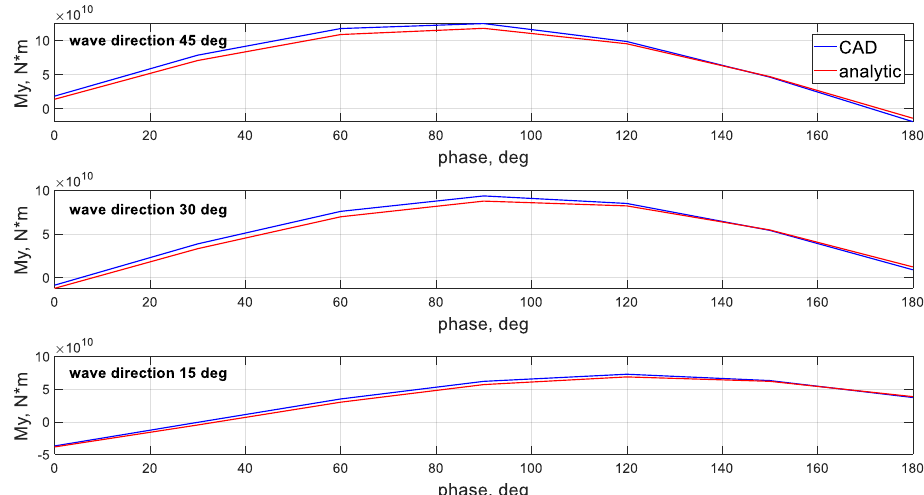
Figure 5. A comparison of bending moments between the CAD and analytical models, for three wave directions: 45° (top), 30° (middle), 15° (bottom).